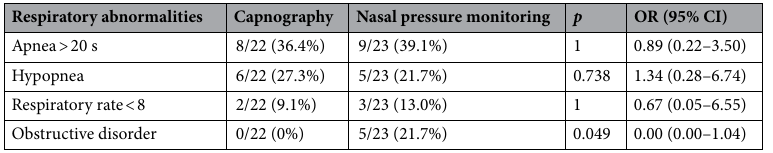
Table 5. Respiratory abnormalities when SpO 2 decreases to < 90%. Values are presented as the number of events/ n (%). Multiple respiratory abnormalities were sometimes detected in one event. CI confidence interval, OR odds ratio, SpO 2 peripheral capillary oxygen saturation.